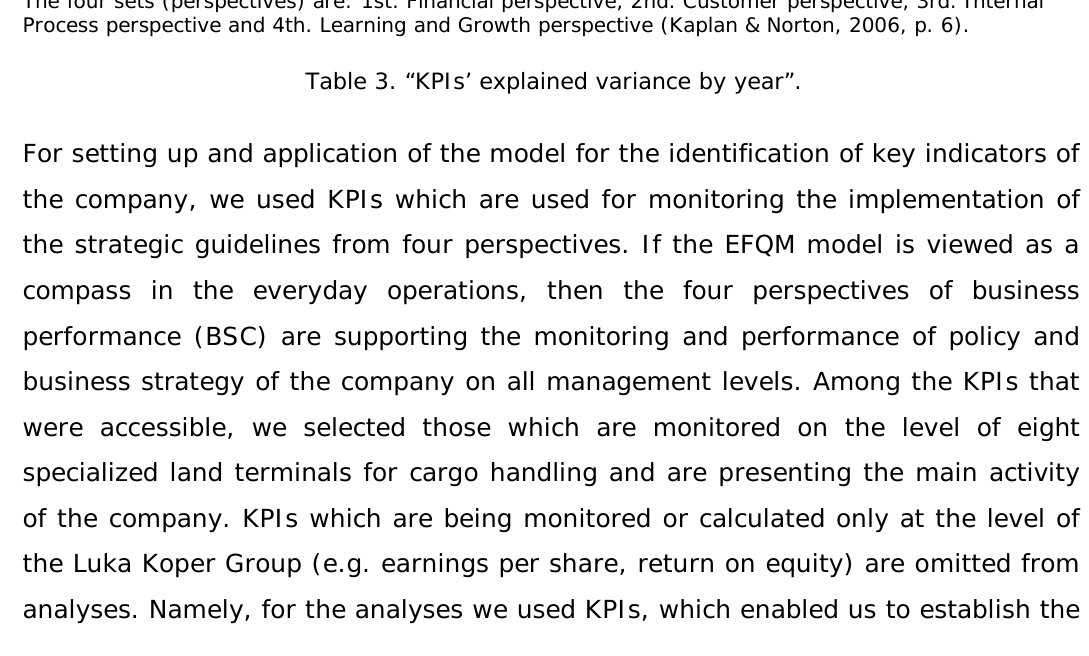
Table 3. “KPIs’ explained variance by